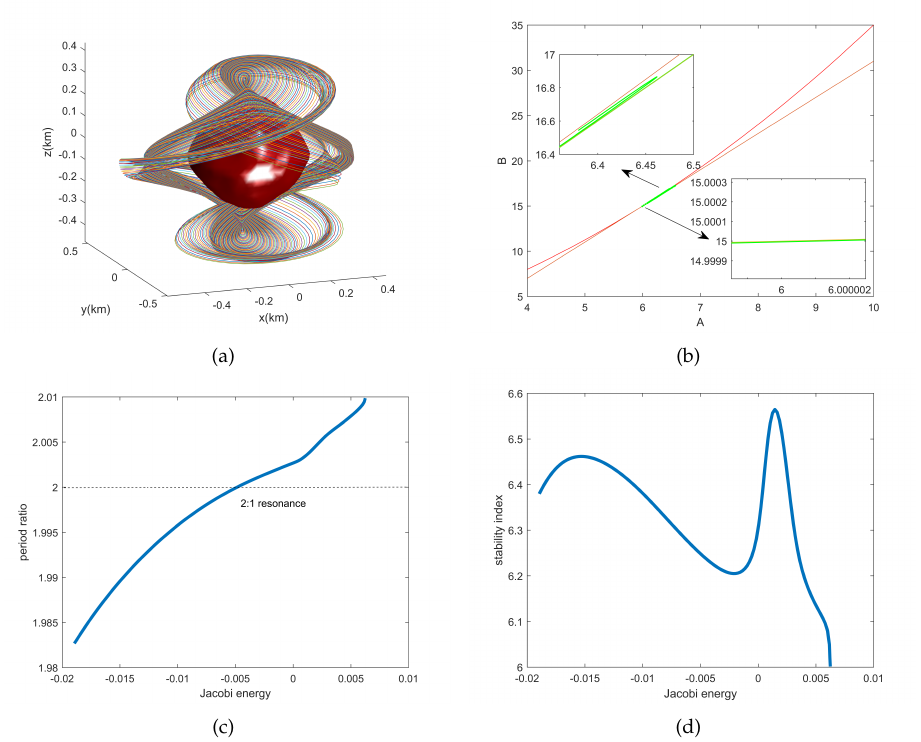
Figure 4. Periodic orbits during the continuation process of the 2:1 resonant family near 101955 Bennu: ( a ) sample of orbits in the rotating coordinate, ( b ) variation paths of (A, B) in the plane, ( c ) the variation of period ratios during continuation, ( d ) the variation of stability index with respect to the Jacobi energy. The unit for the Jacobi energy is m 2 · s − 2